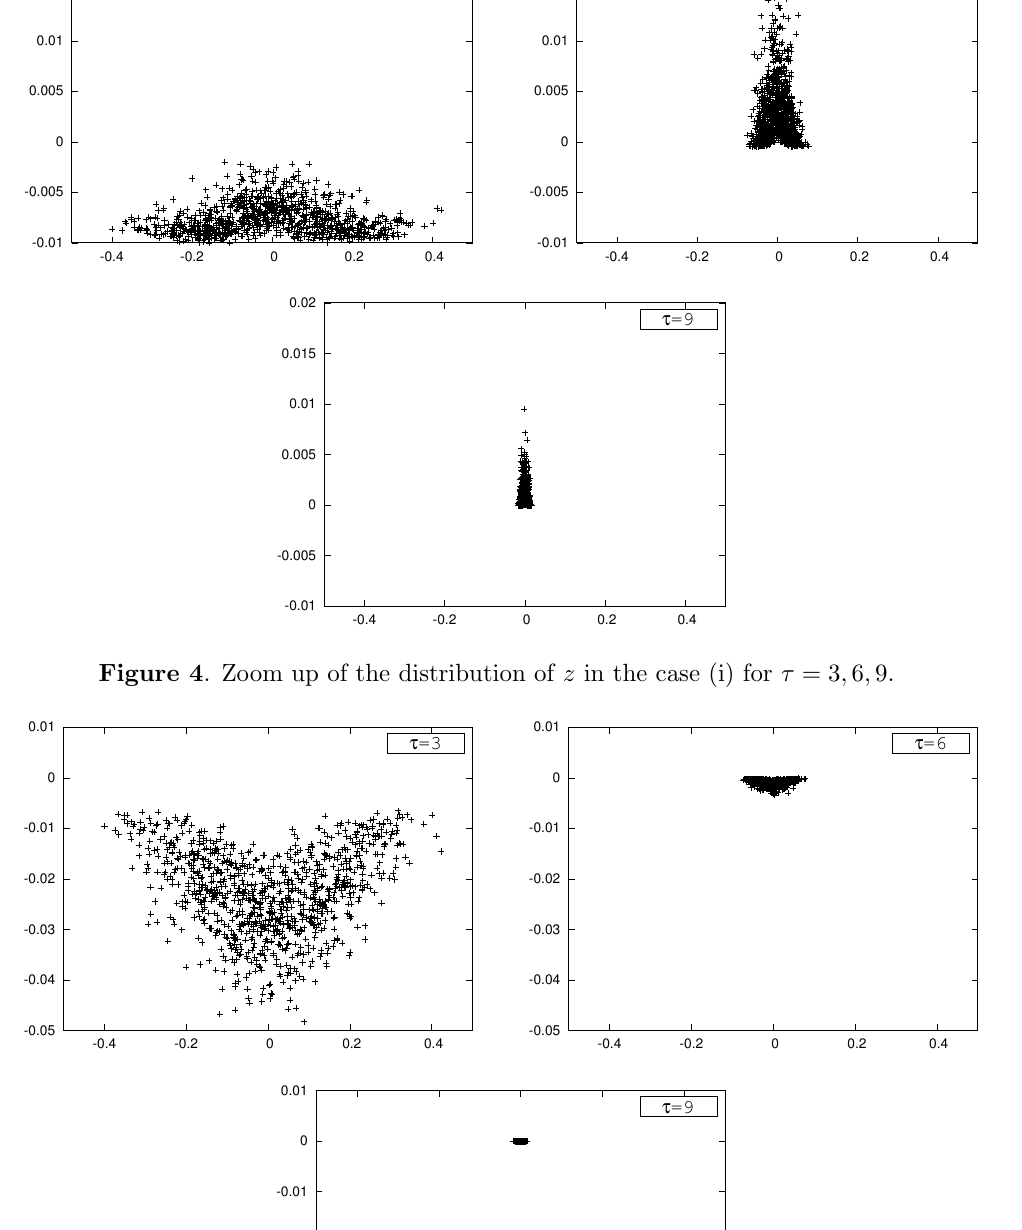
Figure 5 . Zoom up of the distribution of z in the case (ii) for (cid:28) = 3 ; 6 ;